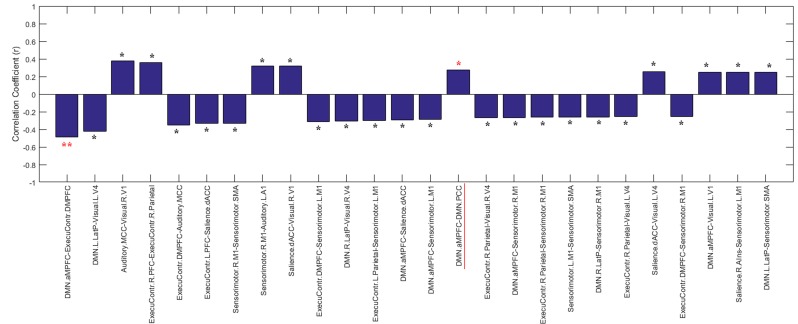
The functional connectivity features sorted by their Pearson's correlations to the CRS-R scores at the T1 time point across the DOC patients in the training dataset ‘Beijing 750’.